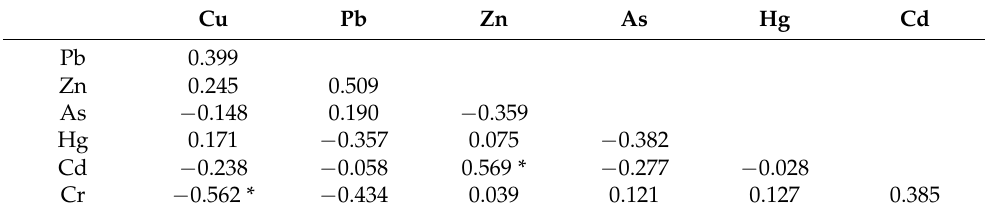
Table 7. The 2018 Pearson matrix of sediment heavy metal variables correlation.